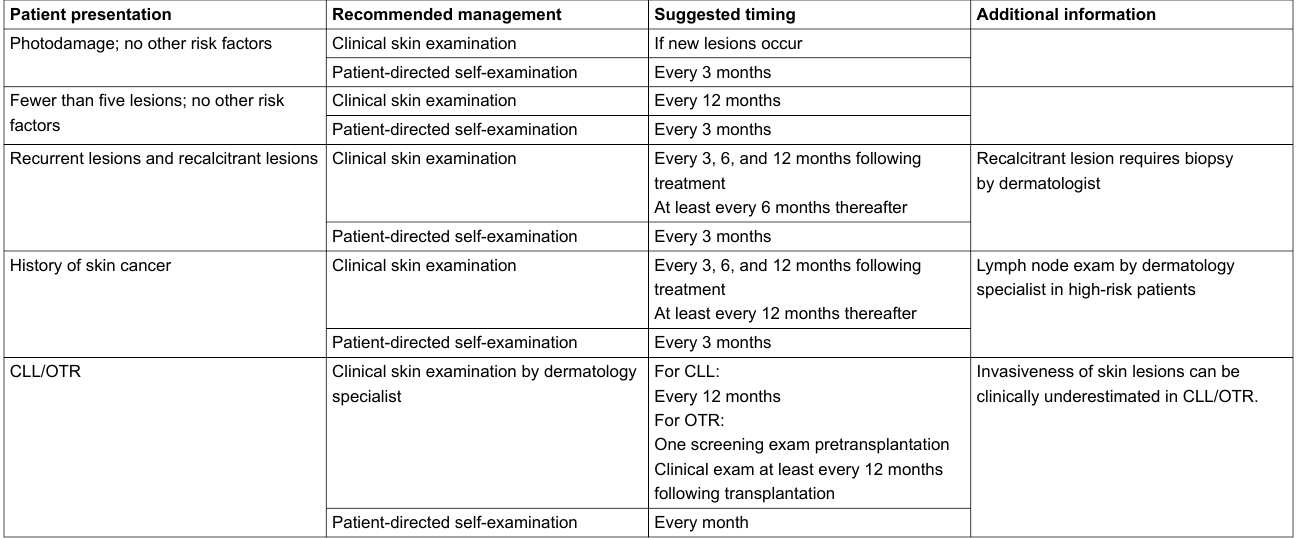
Table 1: Management recommendations for actinic keratosis and field cancerization. Patient